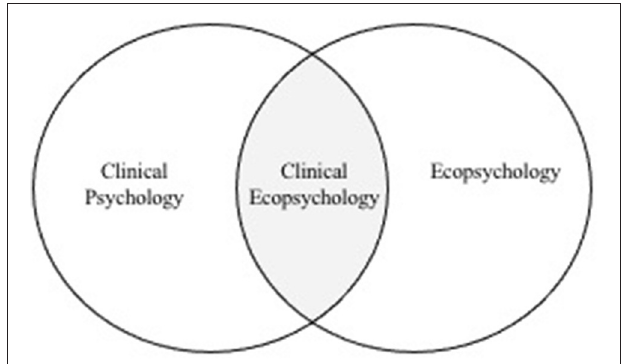
FIGURE 1 | Placement of the research field “Clinical Ecopsychology” between “Clinical Psychology” and